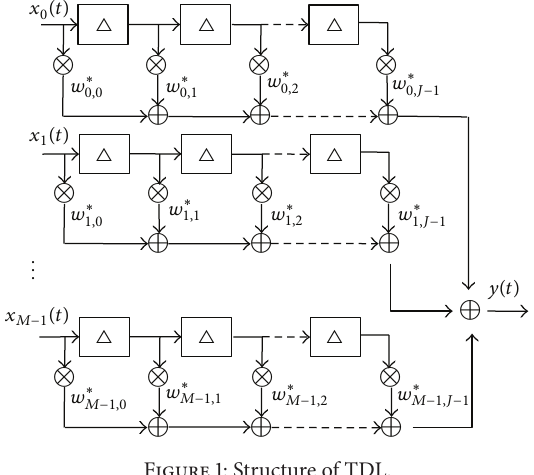
Figure 1: Structure of